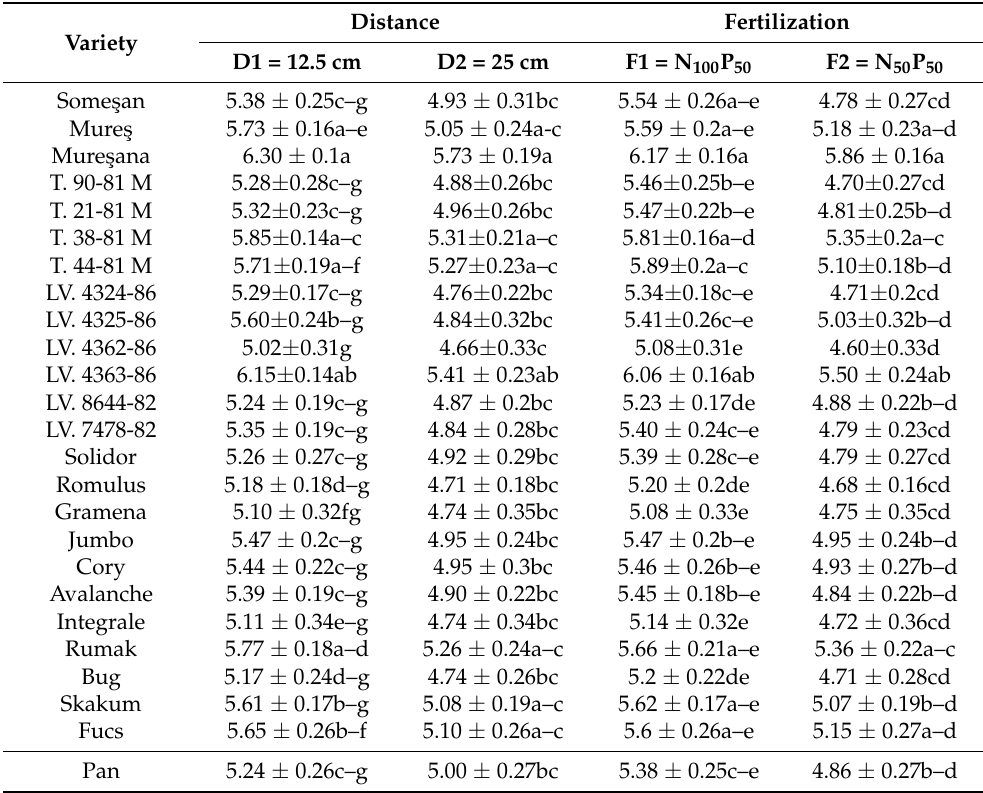
Table 5. Yield performance of spring oat varieties in different conditions of distance sowing and